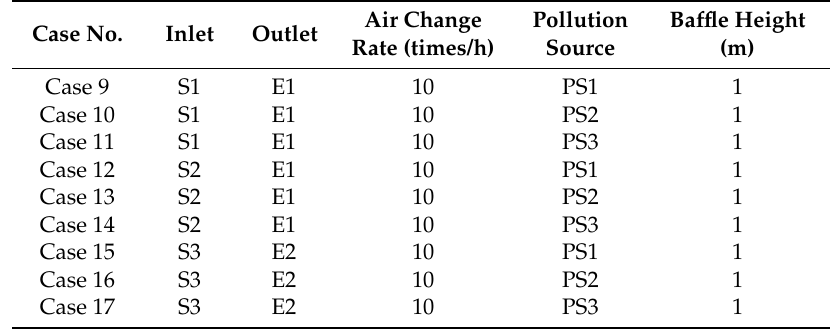
Table 5. Case setup (Model II).